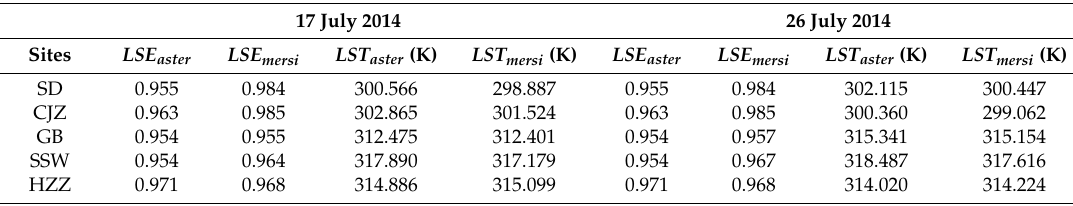
Table 4. LSE estimated from AST_05 or the new method on 17 and 26 July 2014, as well as the corresponding LST.